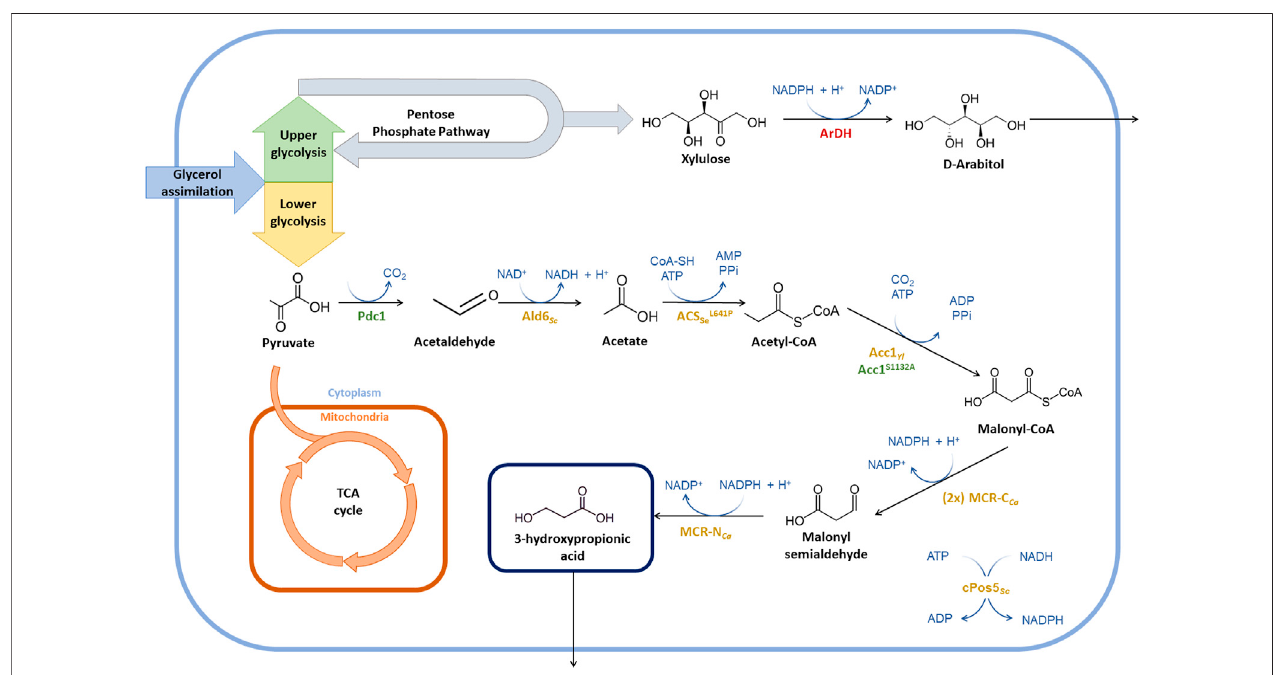
FIGURE1| Summaryofmetabolicengineeringstrategiesfortheoptimisationof3-HPproductionin P.pastoris .Strainengineeringstartedfromthe3-HPproducing strainPpHP6containingthemalonyl-CoAto3-HPpathway(Finaetal.,2021).Heterologousenzymesaredepictedinyellow,endogenousenzymesbeingoverexpressed are shown ingreen, and the enzymes catalyzing thereactionsof genesbeing deletedare shown in red. The (2x)indicates thata second copy of theMCR-C Ca gene was introduced. Enzyme abbreviations:Pdc1, pyruvate decarboxylase; Ald6 Sc , aldehyde dehydrogenase from S. cerevisiae ; ACS Se L641P ,acetyl-CoA synthase from S. enterica with the mutation L641P; Acc1 Yl , acetyl-CoA carboxylase from Y. lipolytica ; Acc1 S1132A , acetyl-CoA carboxylase from P. pastoris with the mutation S1132A; MCR-C Ca , C-terminal domain of the malonyl-CoA reductase from C. aurantiacus ; MCR-N Ca , N-terminal domain of the malonyl-CoA reductase from C. aurantiacus ; cPos5 Sc , NADH kinase from S. cerevisiae relocated into the cytoplasm; ArDH, D-arabitol dehydrogenase.